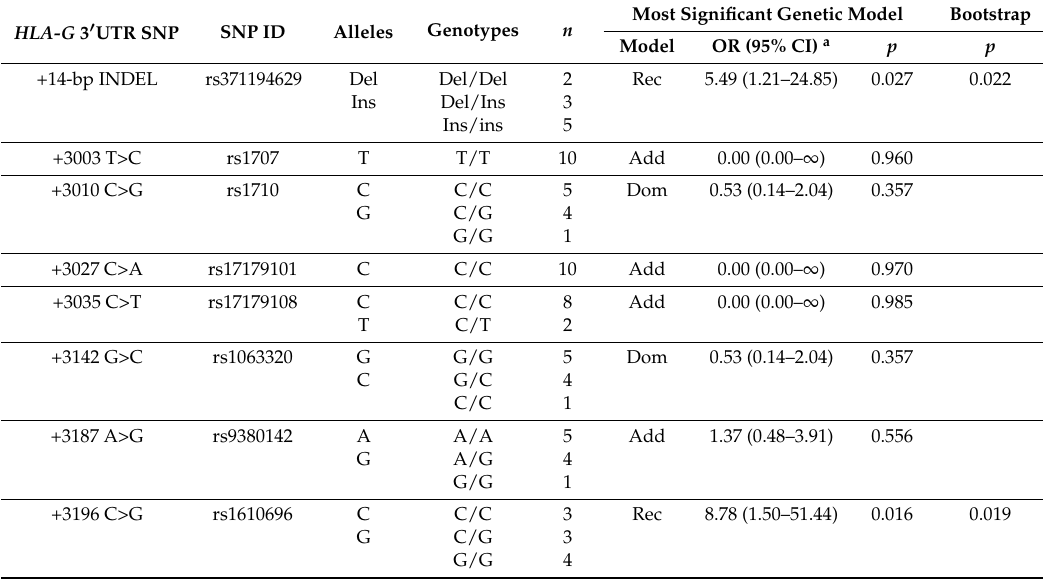
Table 5. Associations between HLA-G 3 (cid:48) UTR SNPs and G3-4 neurotoxicity.